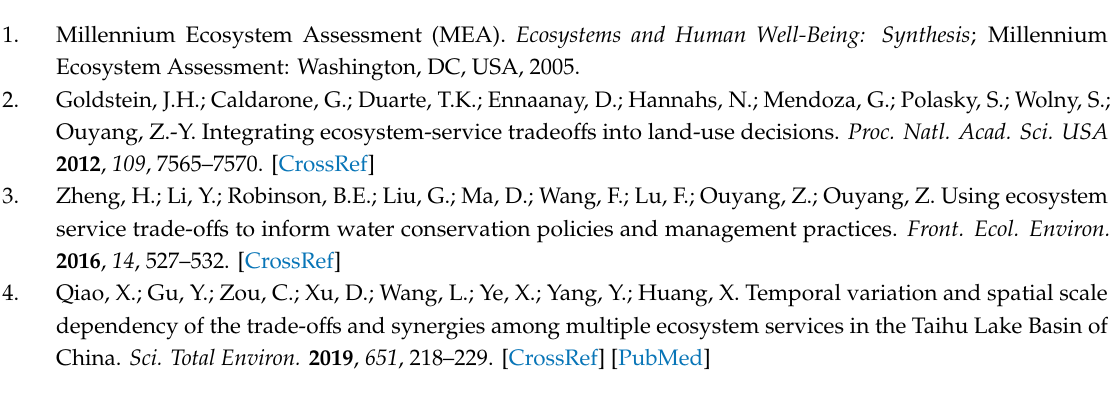
Table S1: Respondents characteristics, Table S2: Temporal changes of NPP, soil conservation, forest recreation, and habitat quality from 2005–2015 in Huailai County, Table S3: Habitat quality score in the year of 2000, 2010, and 2015 in Huailai County, Figure S1: Gross production of crop, vegetable, fruit, and meat from 2005–2015 in Huailai